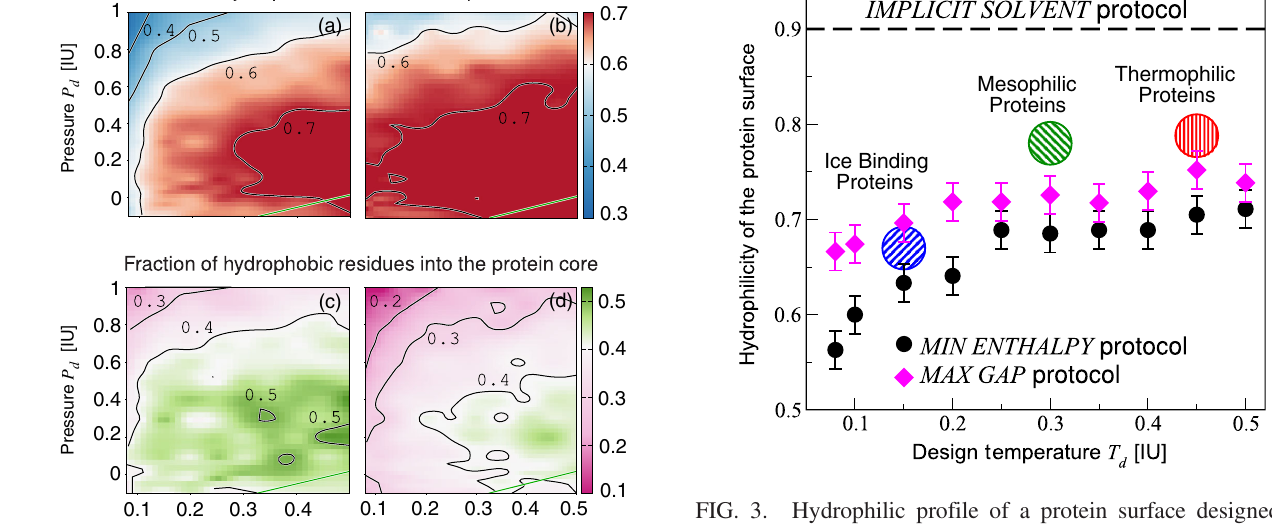
FIG. 3. Hydrophilic profile of a protein surface designed at ambient pressure. The fraction P PHI ð T d ; P d Þ of surface hydro- surf philic amino acid decreases with the design temperature T d , for both the design protocols MIN ENTHALPY (black circles) and FIG. 2. Hydropathy profile of the designed protein surface and MAX GAP (diamonds). Data are from Figs. 2(a) and 2(b) at core. The color-coded contour plots of the fraction P PHI ð T d ; P d Þ surf P ¼ 0 . Our results qualitatively follow the trend observed for the of surface hydrophilic amino acid [panels (a) and (b)] and the T ; P average hydropathy of real thermophilic [58] (large red circle), fraction Q PHO d d Þ of core hydrophobic amino acid [panels core ð mesophilic [58] (large green circle), and ice-binding proteins [59] (c) and (d)] as a function of the design temperature T d and (large blue circle), plotted at high T ( T ¼ 0 . 45 IU), intermediate pressure P d , calculated with both design protocols, MIN EN- T ( T ¼ 0 . 3 IU), and low T ( T ¼ 0 . 15 IU), respectively, to ease THALPY [panels (a) and (c)] and MAX GAP [panels (b) and the comparison. Such values of T resemble the average working (d)], show a stronger segregation between the hydrophilic surface temperature of real thermophilic, mesophilic, and ice-binding and the hydrophobic core for proteins designed at high T d and proteins. The hydropathy profile (independent of T d ) of sequen- low or intermediate P d . The straight (green) line in the lower- ces designed with implicit solvent (dashed line) is unable to right corner of each panel marks the liquid-gas spinodal line of reproduce the observed trend. the solvent. T d and P d are expressed in internal